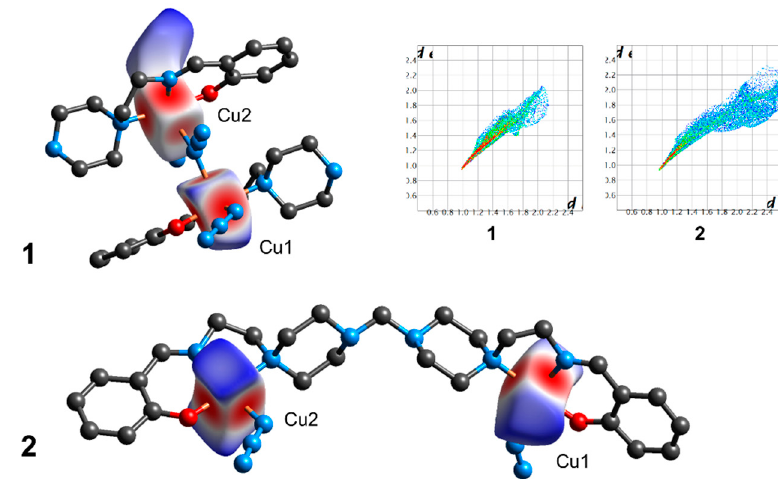
Figure 8. The Hirshfeld surface of copper centres in 1 and 2 . The coloured map corresponds to a normalized contact distance ( d norm ), ranging from − 0.67 to 0.87 (for 1 ) and − 0.69 to 1.64 (for 2 ). The inset shows the fingerprint plots ( d e vs. d i , Å) for each copper atom